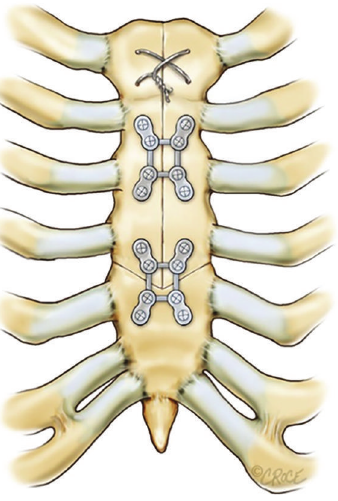
Figure 2: Arrowhead sternotomy closure with a rigid sternal fixa- tion